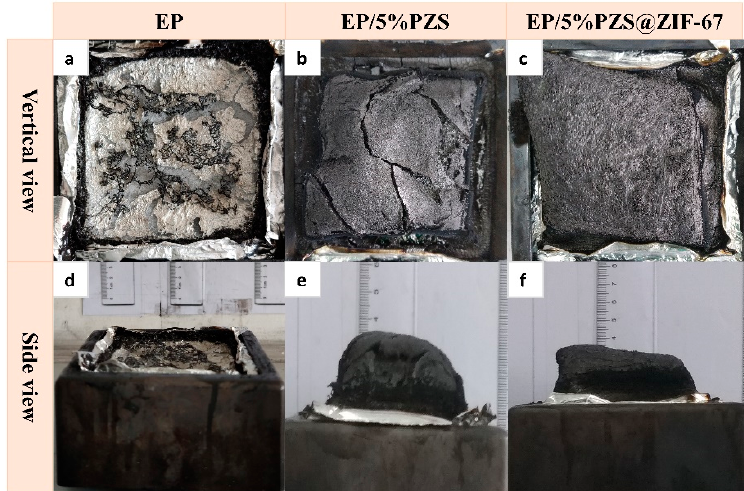
Figure 8. ( a ) Vertical view and ( d ) front view of EP char residue after the cone calorimeter test, ( b ) Vertical view and ( e ) front view of EP/5% PZS char residue after the cone calorimeter test, ( c ) Vertical view and ( f ) front view of EP/5% PZS@ZIF-67 char residue after the cone calorimeter test, respectively.